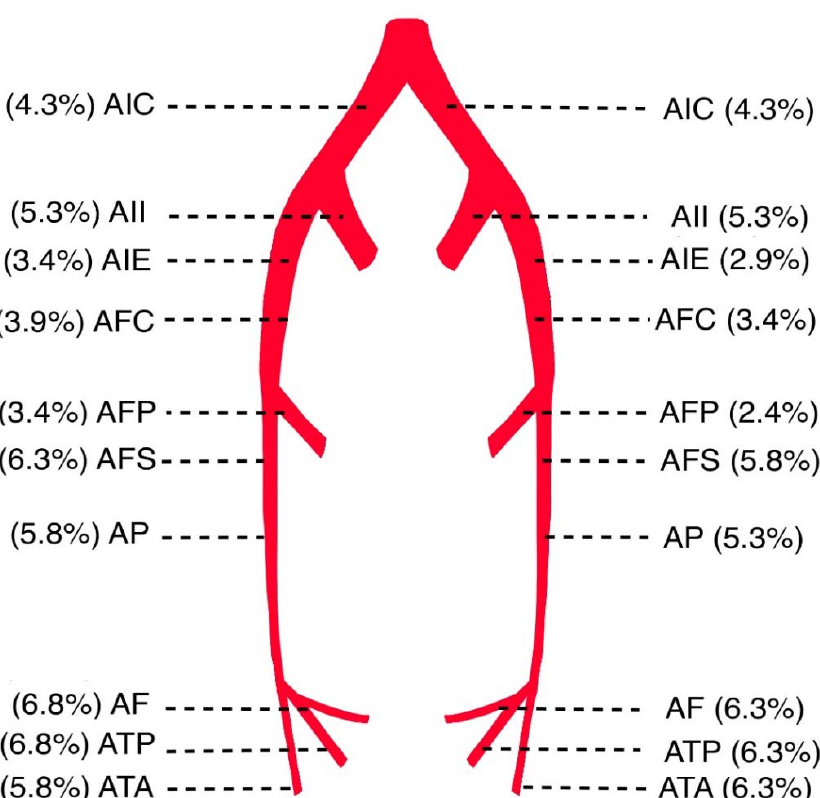
Figure 1. Frequency of arteries affected by arterial thrombosis in patients of the study population.